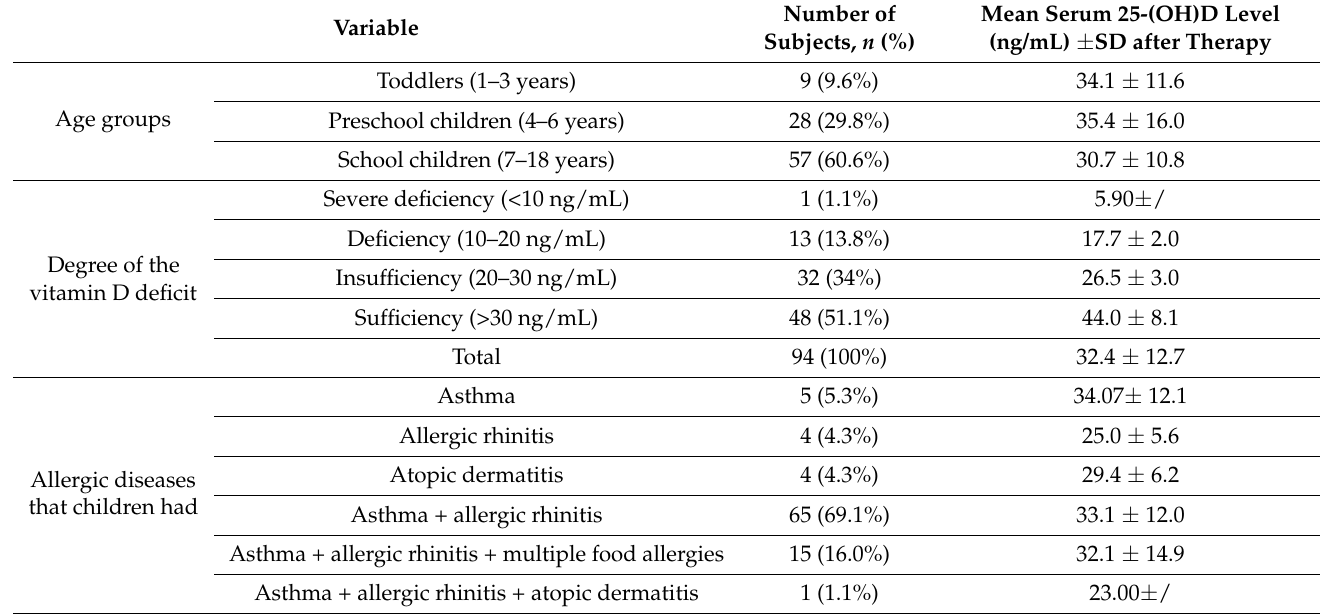
Table 2. Serum levels of 25-(OH)D3 after vitamin D supplementation.